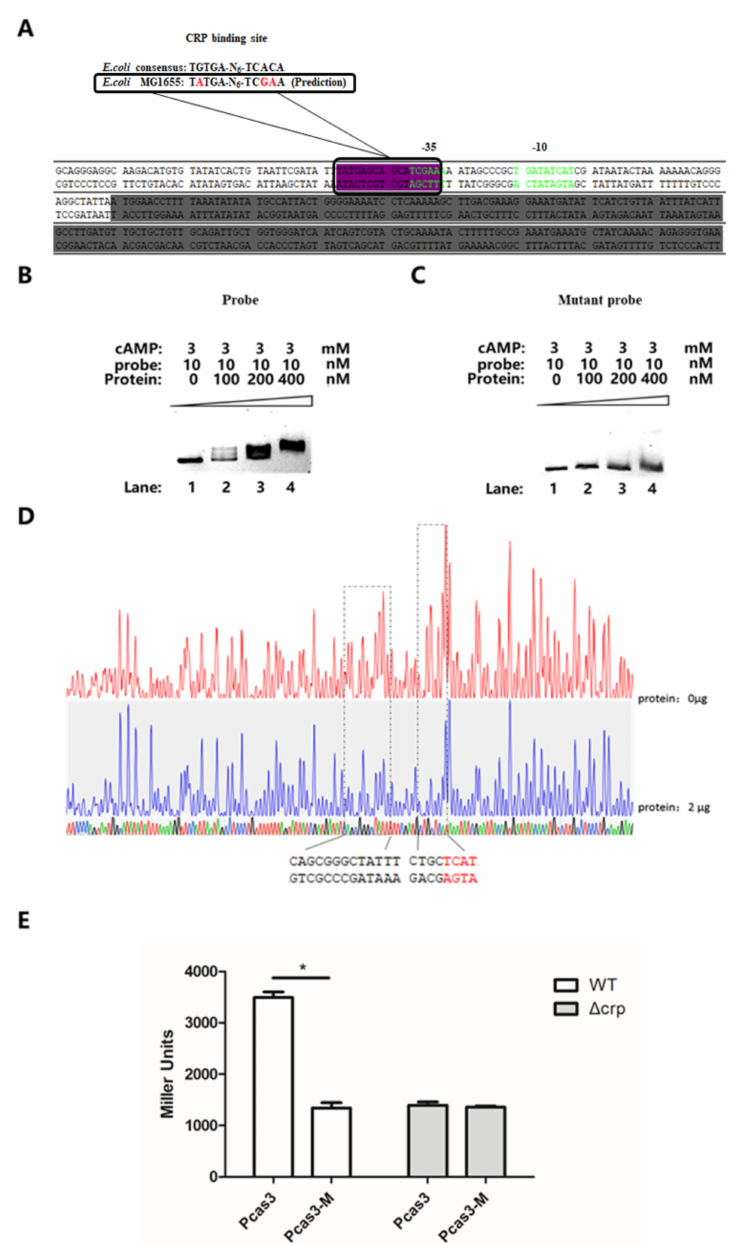
Figure 6. CRP activates cas3 expression by binding to the transcriptional initiation area. ( A ) The transcriptional initiation area of cas3 . The green area represents the predicted cas3 promoter. The purple area represents the putative core binding site of the CRP–cAMP complex. The grey area represents a part of the open reading frame of cas3 . ( B ) The EMSA for evaluating the binding ability of CRP–cAMP to the putative binding site. In the original probe group, at least 400 nM CRP protein was required for the entire shift of the 10 nM probe. ( C ) The EMSA for evaluating the binding ability of CRP–cAMP to the probe, which was amplified from the mutant sequence of the putative binding site. 400 nM CRP protein was incapable to shift the mutant probe. ( D ) The DNase I footprinting assay for sequencing the exact binding motif of CRP–cAMP. The nucleotides in red were consistent with the predicted binding site. ( E ) The β -gal activity of the original and mutant cas3 promoter was measured by reporter plasmids in WT (EC19) or ∆ crp (EC69). The activity of mutant cas3 promoter was almost 3.5 times lower than the original cas3 promoter. All the data were mean ± SEM of at least three replicates, and the p value (* p < 0.05) was analyzed by the t